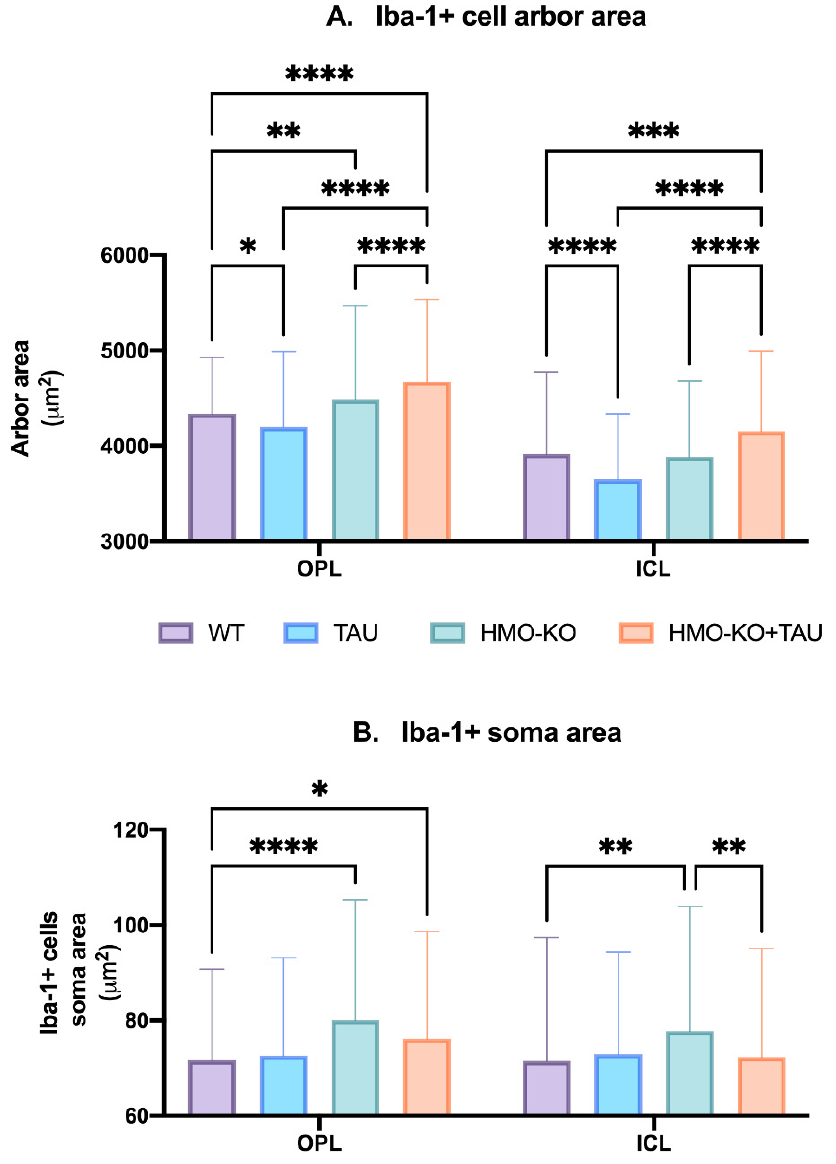
Figure 6. ( A ) Arbor area of Iba-1+ microglia in OPL and ICL in the different study groups. ( B ) Area of the Iba-1+ soma in OPL and ICL in the different study groups. Two-way ANOVA. Data expressed as mean value ( ± SD). * p < 0.05, ** p < 0.01, *** p < 0.001, **** p < 0.0001. Number of retinas used in the experiment: WT n = 6, HMO-KO n = 6, TAU n = 6, and HMO-KO+TAU n = 6. Microglial Soma Area